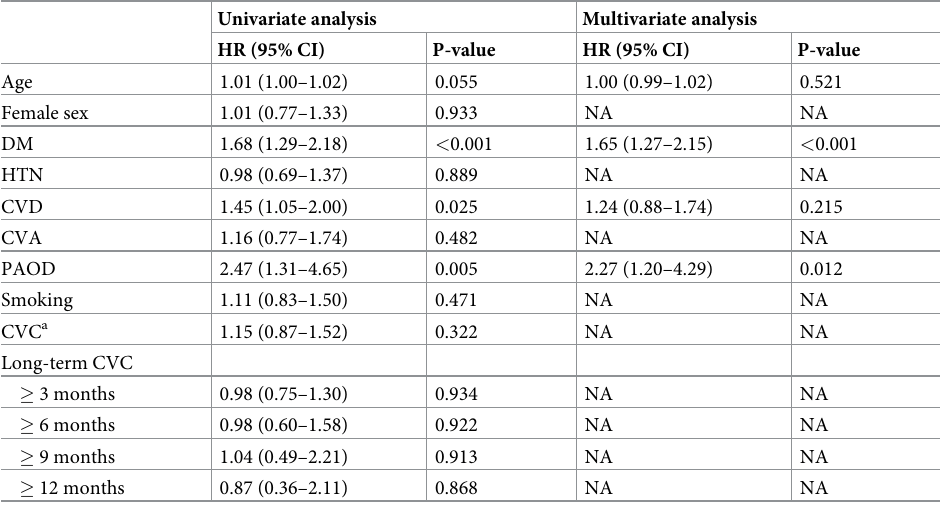
Table 3. Factors associated with secondary patency in the study